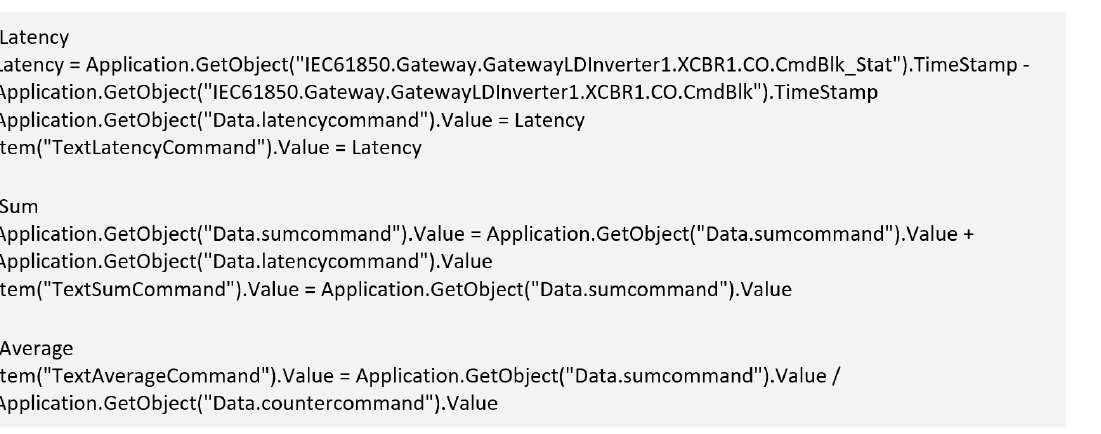
Figure 18. Latency calculation for